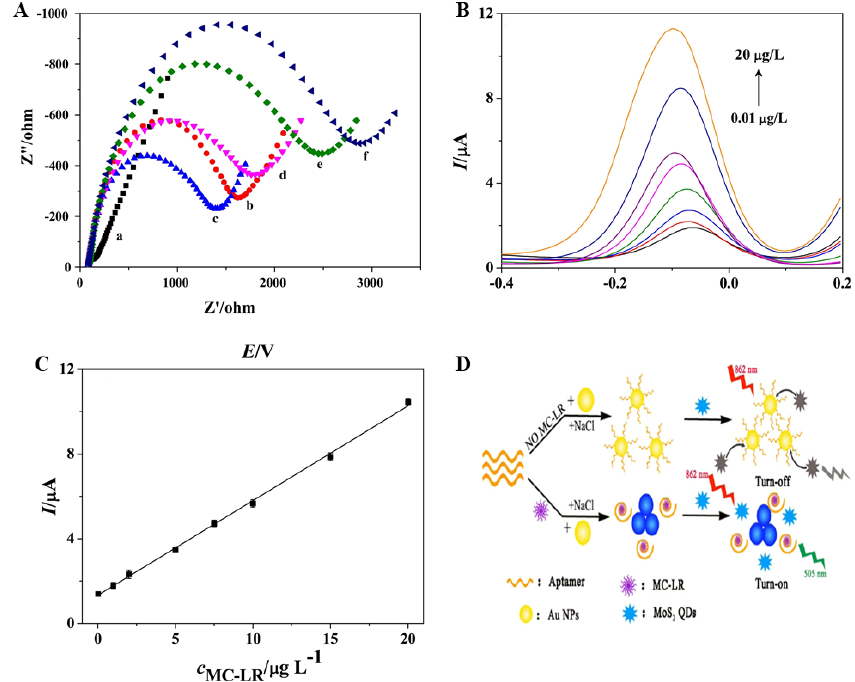
Figure 5. ( A ) Nyquist plots of (a) bare Au electrode, (b) MoS2/Au, (c) AuNRs/MoS2/Au, (d) anti- MC-LR/AuNRs/MoS2/Au, (e) MC-LR/anti-MC-LR/AuNRs/MoS2/Au, and (f) HRP–anti-MC- LR/MC-LR/anti-MC-LR/AuNRs/MoS2/Au in 20 mM PBS (pH 7.5, 0.10 M KCl) containing 5.0 mM [Fe(CN) 6 ] 3 − /4 − and 0.10 M NaClO4 within frequency range of 0.1 Hz to 100 kHz, amplitude of 0.05 V, and applied potential of 0.20 V. ( B ) DPV responses of the immunosensor in 20 mM PBS (pH 7.5, 100 mM NaClO 4 and 100 mM KCl) containing 0.8 mM HQ and 2.0 mM H 2 O 2 after incubation with (0.01 ~ 20.0 μ g L − 1 ) MC-LR. ( C ) Calibration curve for MC-LR immunoassay. The DPV measurements were performed from − 0.4 V to 0.2 V, with an amplitude of 50 mV and a pulse width of 50 ms. ( D ) Schematic representation of the detection strategy of MC-LR according to MoS 2 QDs using up conversion fluorescence and aptamer–AuNPs. Reproduced with permission from [109] published by Elsevier, 2017, and [113] published by American Chemical Society,